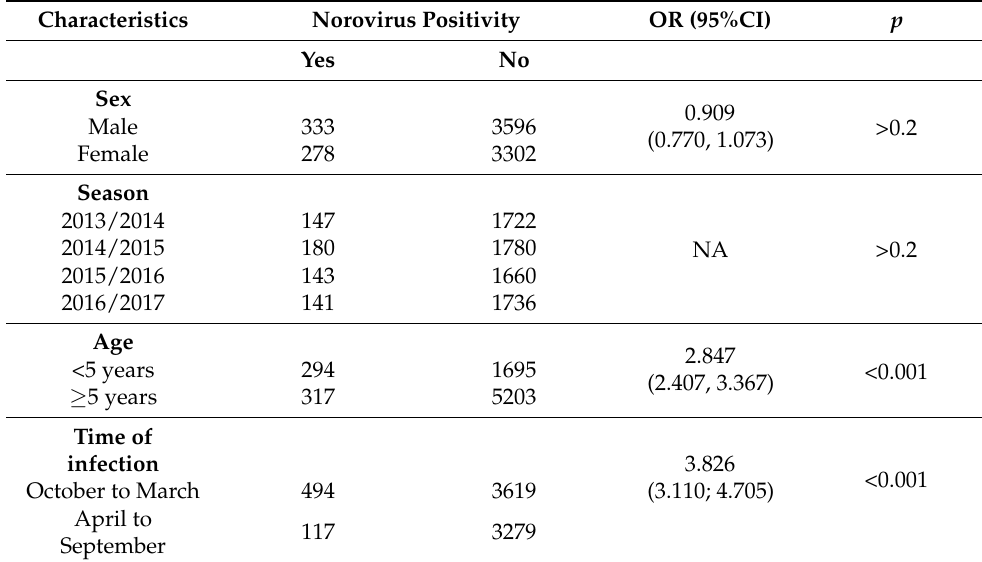
Table 1. Analysis of Characteristics of 7509 Patients with Gastrointestinal Complaints.